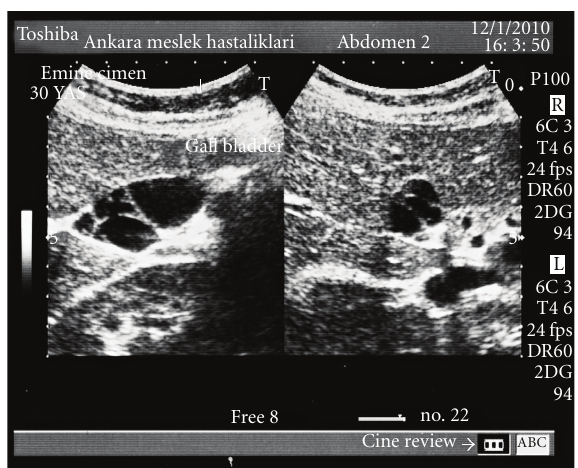
Figure 1: Multiple linear echoes mimicking honey-comb pattern.